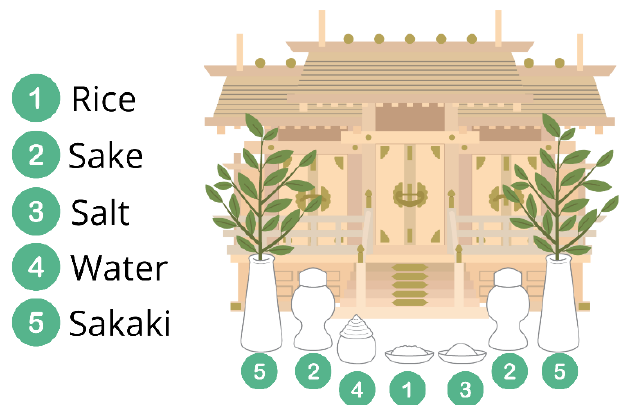
Figure 1. Diagram of traditional offerings listed in order of placement on the kamidana . Source: author.